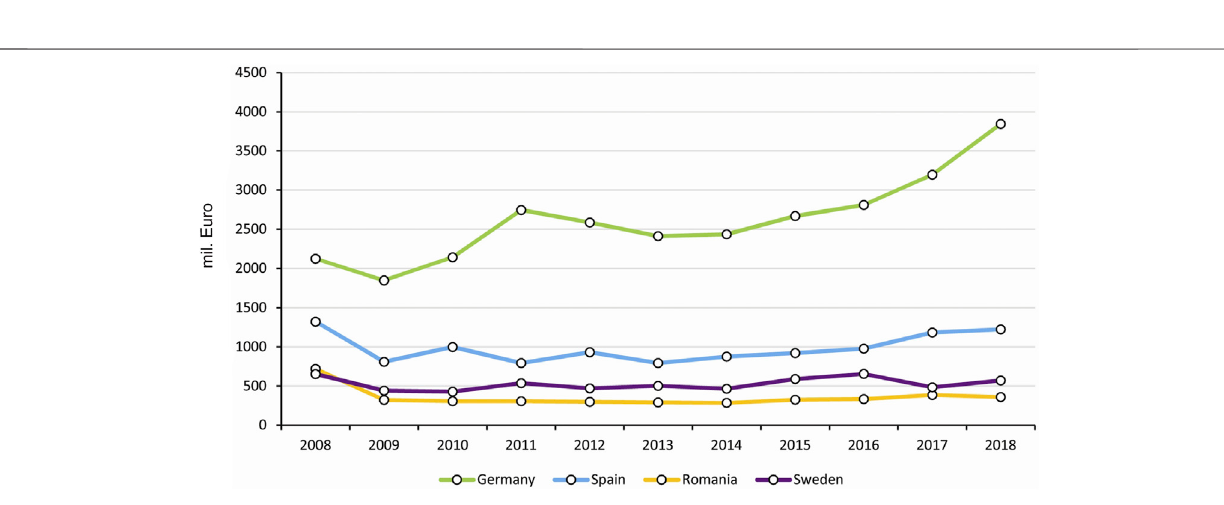
Frontiers in Environmental Science |